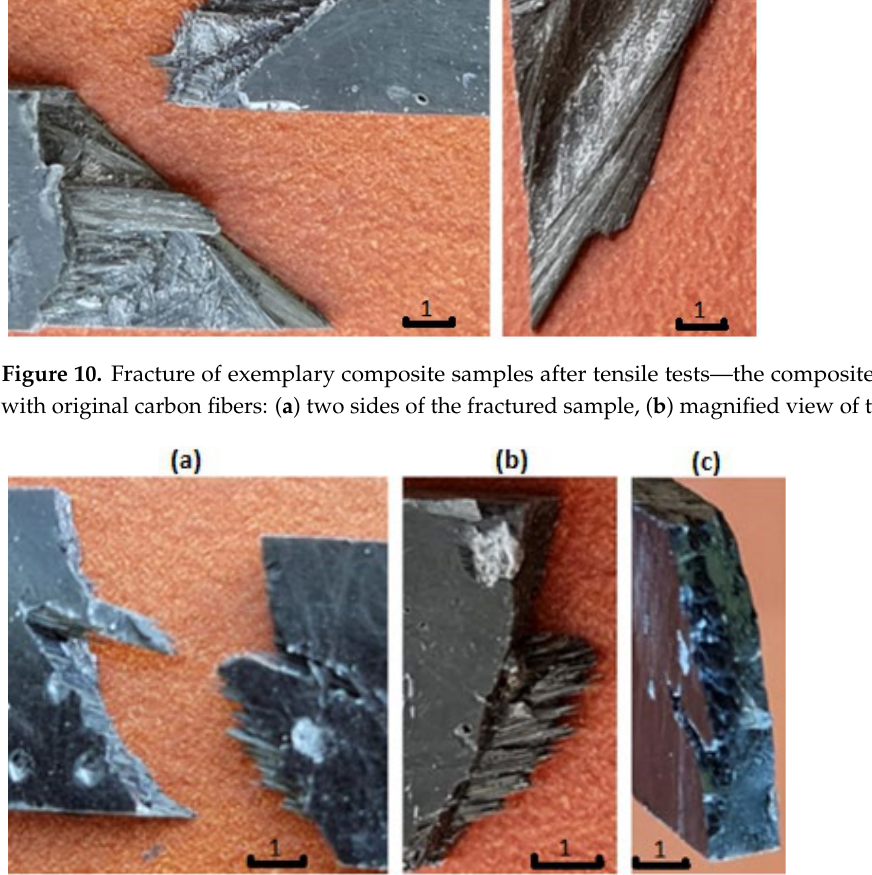
Figure 11. Fracture of exemplary composite samples after tensile tests—the composite reinforced with the pyrolytic carbon fibers: ( a ) two sides of the fractured sample, ( b ) view of a brittle fracture and the pulled-out fiber strands, ( c ) view of a brittle fracture with visible “holes” left by the pulled-out fiber strands .